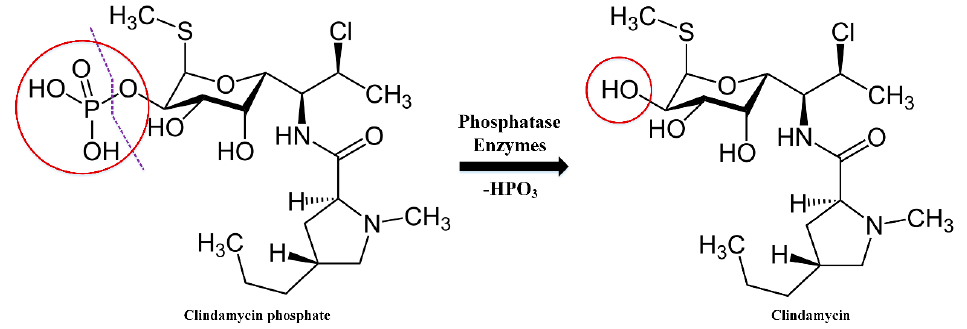
Figure 1. Clindamycin phosphate hydrolysis mechanism.